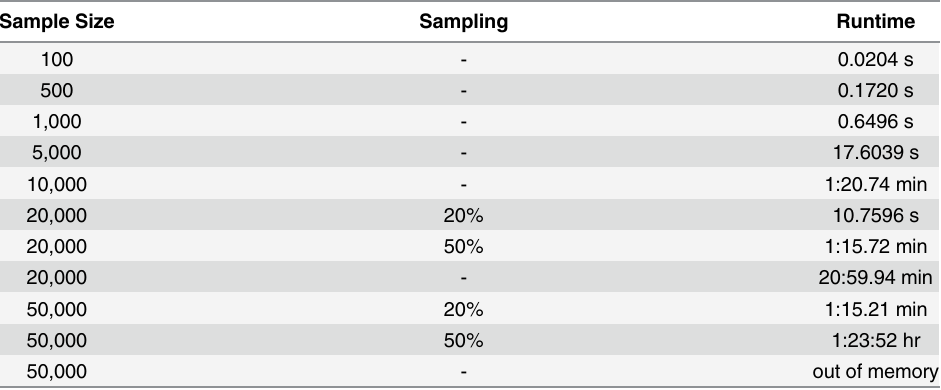
Table 1. Runtime